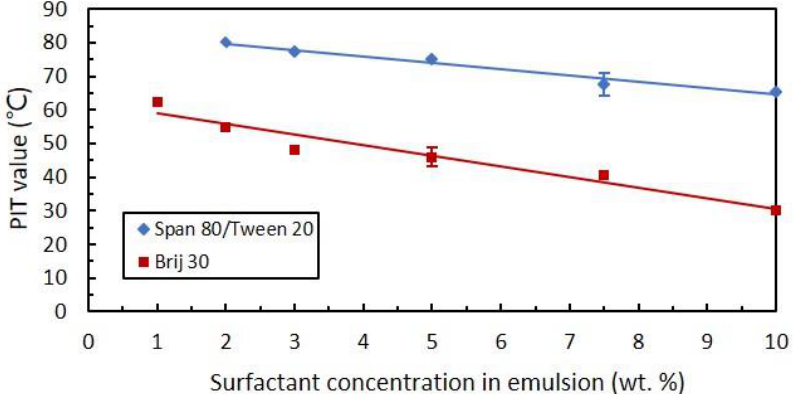
Figure 4. Comparison of PIT values corresponding to various concentrations of the surfactant Span 80/Tween 80 to the O/W emulsion of silicone oil.